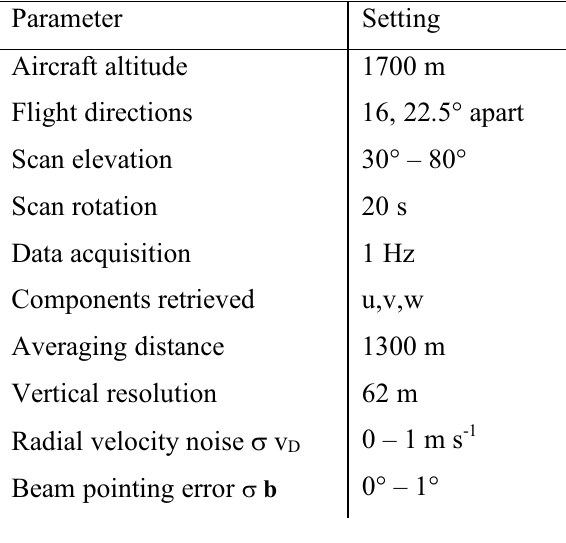
Table 1: System setup and retrieval parameters as used for this study.